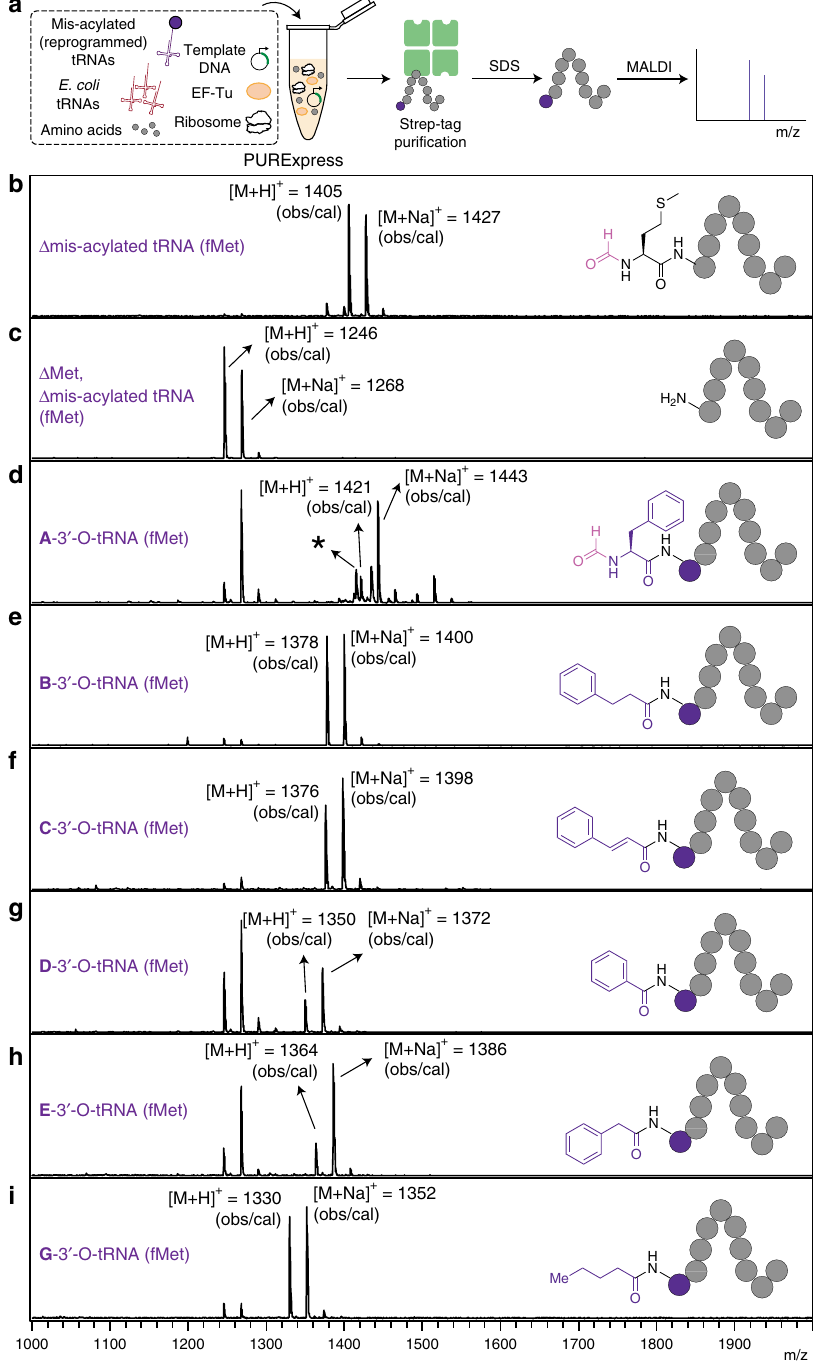
The MALDI spectrum shows only a single species for the synthesized peptide giving a mass of 1246 ([M + H] + ) and 1268 Da ([M + Na] + ) (Fig. 5c). The observed peaks correspond to the theoretical mass of a peptide with sequence WHSPQFEKST,